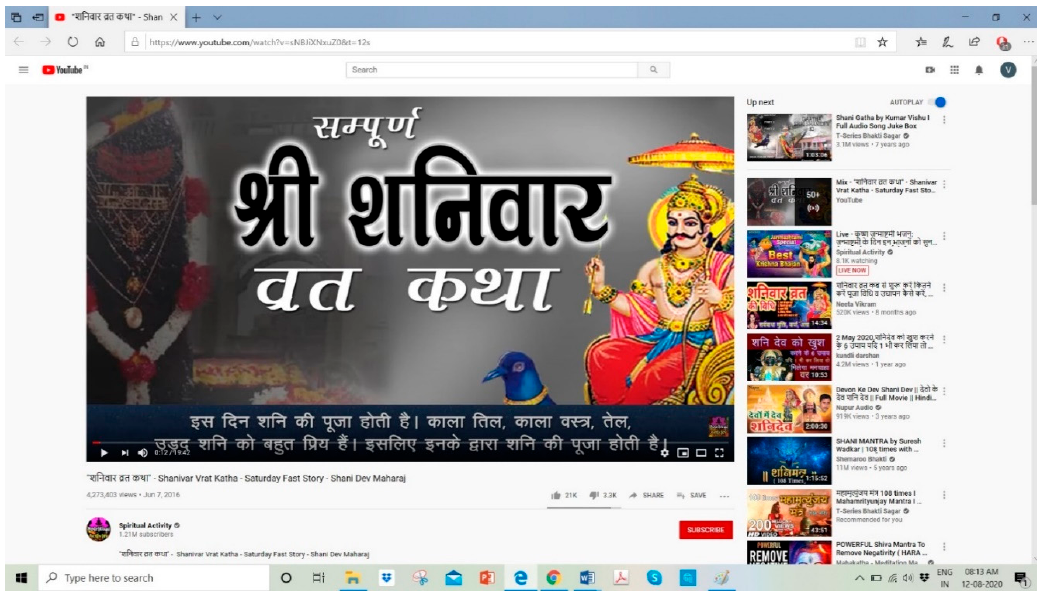
Figure 8. Screenshot of YouTube video ‘Sampoorna Shanivar ki vrat katha’ by the YouTube channel Spiritual Activity, with 1.2 million subscribers.